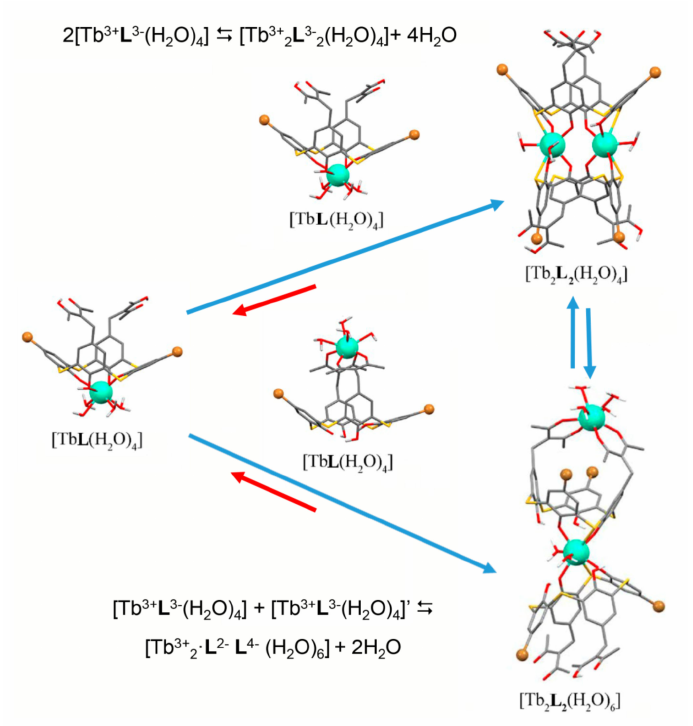
Figure 4. Schematic presentation of the equilibration between monomeric complexes [Tb L (H 2 O) 4 ] and dimeric complexes [Tb 2 L 2 (H 2 O) 4 ] and [Tb 2 L 2 (H 2 O) 6 ] ( L = 38 ) in the DMF solutions.